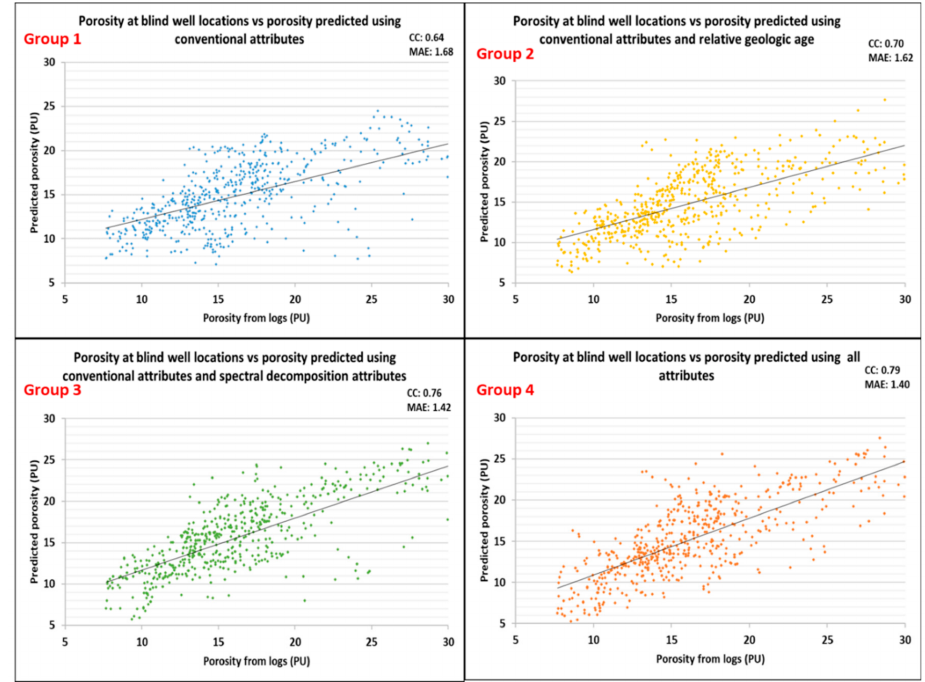
Figure 13. Cross-plots of the actual versus predicted porosity for predictions made using each of the attribute groups in three blind validation wells. Abbreviations: CC, correlation coefficient and MAE, mean absolute error. Data from the entire length of available logs were used in this